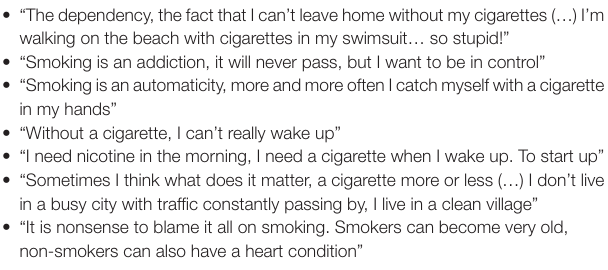
TABLE 9 | Examples of cognitions on